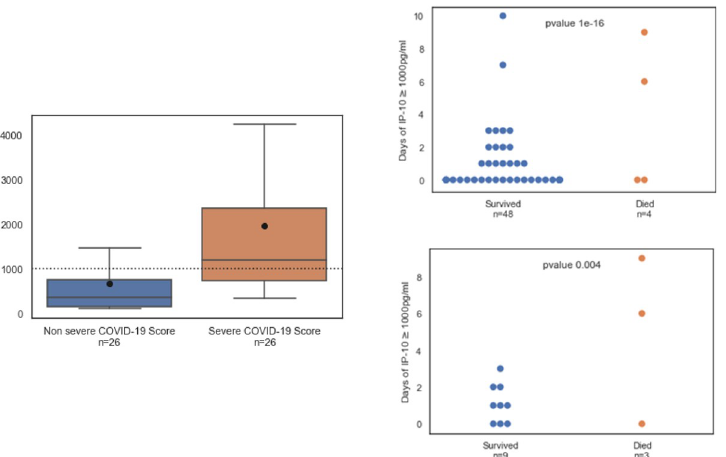
Fig 3. (Left panel) IP-10 levels correlate with COVID-19 severity. Maximal IP-10 levels in patients classified as non severe or severe according to the NIH COVID-19 severity score (https://www.covid19treatmentguidelines.nih.gov/. Accessed August 2020). The black line denotes the group median and the circle corresponds to group mean. The box indicates patients with values between the 25 and 75 percentiles. The whiskers indicate patients with values between the 2.5 and the 97.5 percentiles. (Right panel) Mortality correlates with the number of days when IP-10 levels exceeded 1,000 pg/mL in SARS-CoV-2-positive patients (n = 52, upper panel) and among the subset of intensive care unit (ICU) patients (n = 12, lower panel). IP-10 was measured at various time points during hospitalization. At least one IP-10 measurement � 1,000 pg/mL in a given day was sufficient to classify the day as exceeding 1,000 pg/mL. Each circle represents a patient; blue dots represent patients who survived and red dots represent patients who died. The cause of death of the ICU patient with a low number of days of IP-10 > 1,000 pg/mL was candidemia and of the non- ICU patient was metastatic breast